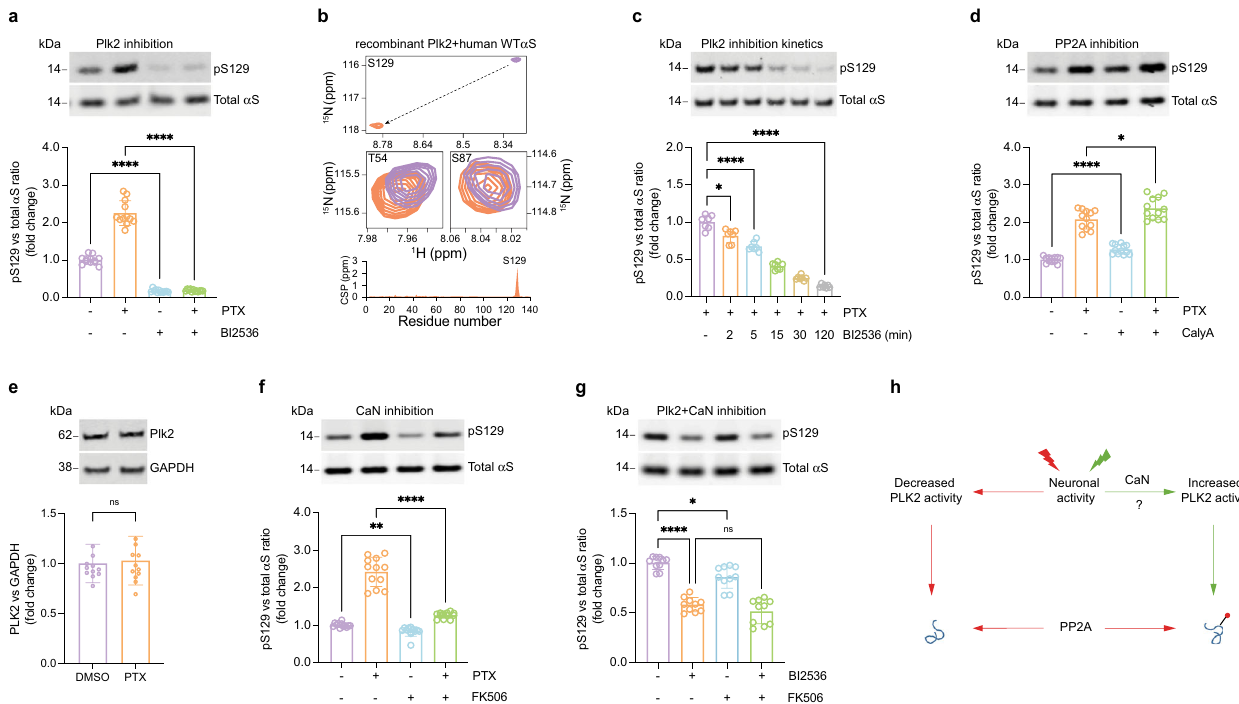
Fig. 3 Activity-dependent pS129 is regulated by Plk2, PP2A, and calcineurin. a DIV17-21 rat cortical neurons treated with 20 µM PTX, 500 nM BI2536 (Plk2 inhibitor) or PTX + BI2536 for 2 h. WB for total α S and pS129. N = 3 independent experiments on different days, n = 12 biological replicates total. * p < 0.1; **** p < 0.0001. Mean + / − SD. Brown-Forsythe and Welch ANOVA with Dunnett ’ s T3 post hoc test for multiple comparisons. b 2D 1 H- 15 N HSQC NMR spectrum of recombinant, N-terminally acetylated human α S in the presence (orange) or absence (purple) of recombinant Plk2 (see “ Methods ” for details and Supplementary Fig. 4). Spectrum in the presence (purple) or absence of Plk2 (orange) is shown for S129 (top), T54, and S87 (middle); residue-resolved combined chemical shift perturbations (CSPs) of backbone amide resonances (bottom). c DIV17-21 rat cortical neurons treated with 20 µM PTX for 2 h and 500 nM BI2536 co-administered for 0, 2, 5, 15, 30, or 120 min. WB for total α S and pS129. N = 2 independent experiments on different days, n = 7 biological replicates total. * p < 0.1; **** p < 0.0001. Mean + / − SD. Brown-Forsythe and Welch ANOVA with Dunnett ’ s T3 post hoc test for multiple comparisons. d 1.5 nM PP2A inhibitor calyculin A (Caly A) treatment for 2 h. WB for total α S and pS129. N = 3 independent experiments on different days, n = 12 biological replicates total. *** p < 0.1; **** p < 0.0001. Mean + / − SD. Brown-Forsythe and Welch ANOVA with Dunnett ’ s T3 post hoc test for multiple comparisons. e DIV17-21 rat cortical neurons treated with 20 µM PTX or DMSO control for 2 h. WB for PLK2 and GAPDH (loading control). N = 3 independent experiments on different days, n = 12 biological replicates. ns not signi fi cant. Mean + / − SD. Unpaired t -test, Welch ’ s correction; two-tailed. f DIV17-21 rat cortical neurons treated with DMSO, 20 µM PTX, 2 µM CaN inhibitor FK506, or both for 2 h. WBs to total α S and pS129. N = 3 independent experiments on different days, n = 12 biological replicates total. ** p < 0.01; **** p < 0.0001. Mean + / − SD. Brown-Forsythe and Welch ANOVA with Dunnett ’ s T3 post hoc test for multiple comparisons. g DIV18 rat cortical neurons treated with 50 nM Plk2 inhibitor BI2536, 2 µM CaN inhibitor FK506, or both for 2 h. WB for total α S and pS129. N = 3 independent experiments on different days, n = 10 biological replicates total. ns not signi fi cant; ** p < 0.01; **** p < 0.0001. Mean + / − SD. Brown-Forsythe and Welch ANOVA with Dunnett ’ s T3 post hoc test for multiple comparisons. h Schematic: the molecular cascade leading to activity-dependent pS129 (see main text for either weak (Fig. 1j) or standard high frequency (Fig. 1k). Strikingly, the EE mice exhibited an increase in pS129 levels relative to total